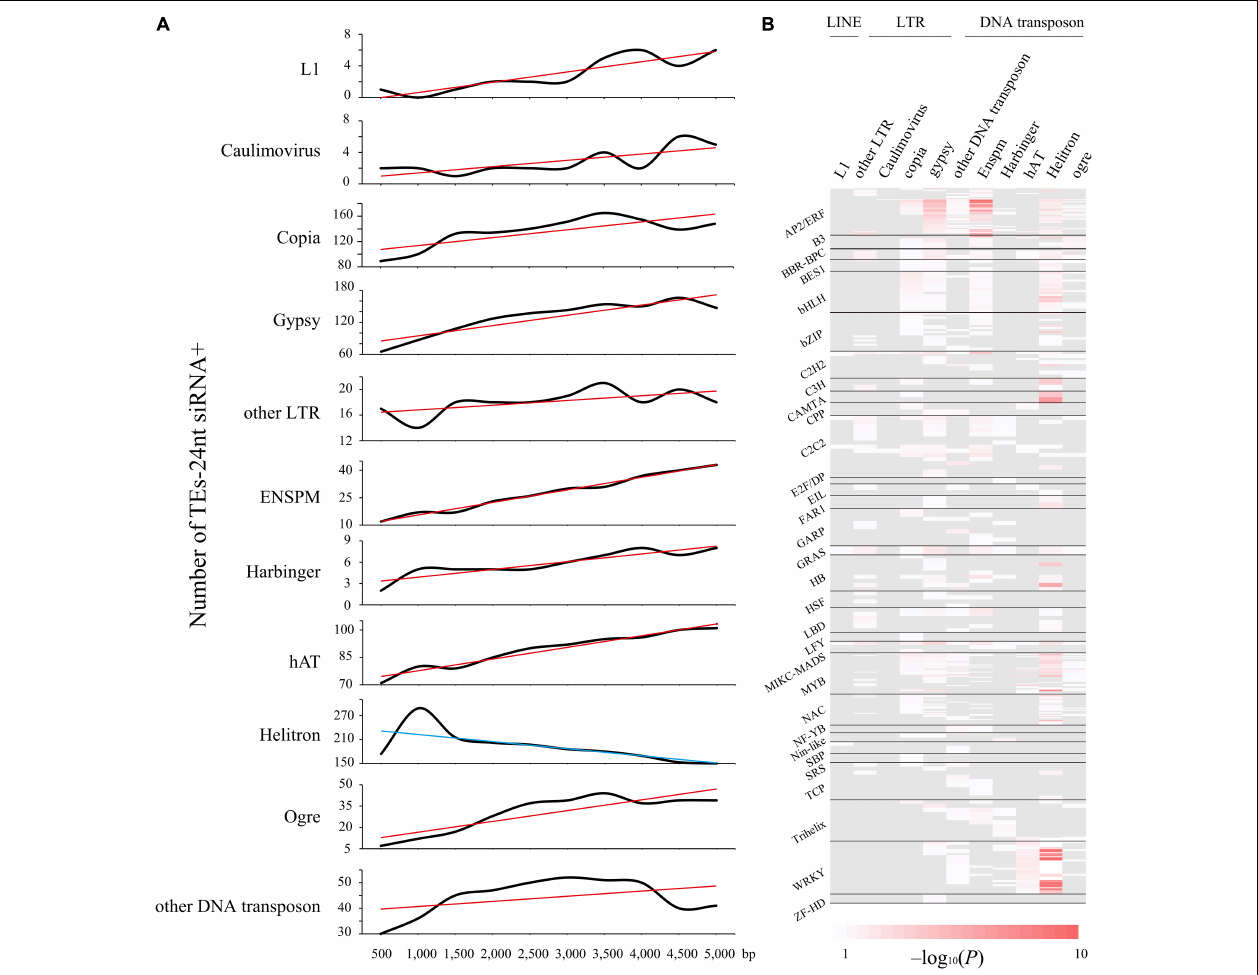
FIGURE 3 | Helitron transposons drive 24-nt siRNAs as a supply of TFBS. (A) The trend of quantity variation of TEs with matching 24-nt siRNAs. TEs distance is in 500-bp bin, up to 5,000-bp. Red and blue lines represent the increasing and declining trend, respectively. (B) Distribution peaks of cis -regulatory elements enriched in the different types of TEs, showing the distribution profile of motifs from 31 transcription factor families significantly ( P < 0.05) enriched in the Helitron type